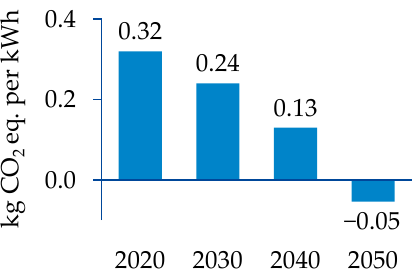
Figure 7. Emission intensity of the electricity grid mix for production and use stage—future projec- tions until 2050 for electricity grid mix in Europe based on premise scenario “SSP2-RCP 2.6”.